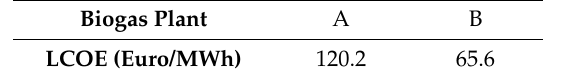
Table 4. Specification of the LCOE ratio value for the analysed agricultural biogas